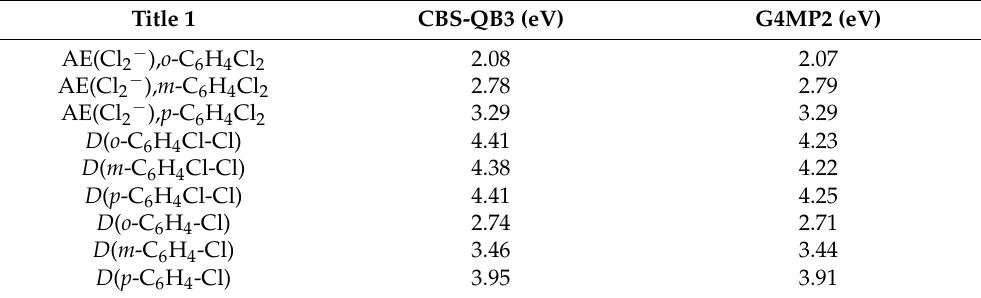
Table 2. Calculated Cl 2 − appearance energies (AE), bond dissociation energies (D) and electron affinity (EA) for hexachlorobenzene at different levels of theory. Values are in